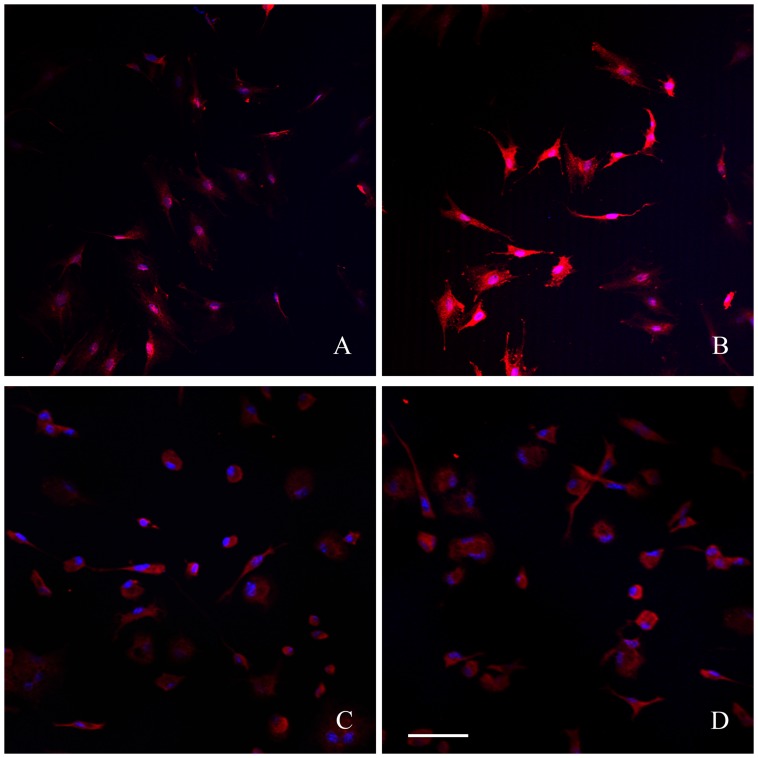
Immunofluorescence staining of MSCs, DCs and both cells in co-culture plates with IL-10.(A) Monoculture of MSCs. (B) MSCs in Transwell co-culture with DCs. (C) Monoculture of iDCs-LPS. (D) iDCs-LPS in Transwell co-culture with MSCs (MSC:DC = 1∶10). Red staining shows IL-10 expression; DAPI blue staining of cell nuclei. Scale bar 251658240 = 251658240100 µm.